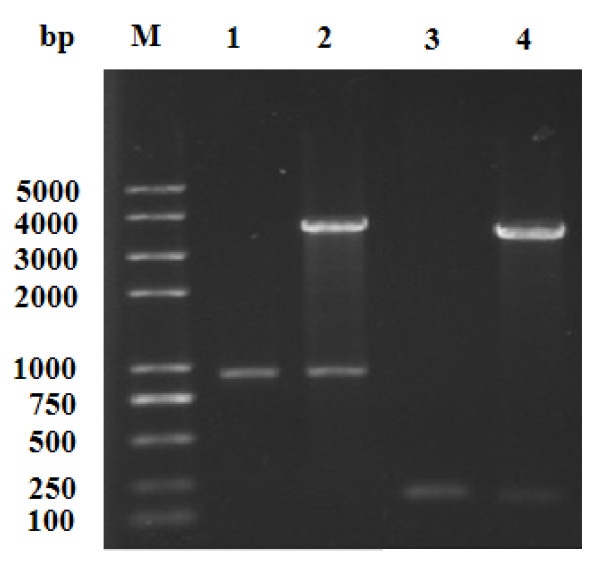
The identification of recombinant plasmid pSK-IE-BmRPSAand pSK-IE-dbp. The dbp or BmRPSA gene was inserted into the transient expression vector pSK-IE. Recombinant plasmid pSK-IE-BmRPSA and pSK-IE-dbp were analyzed by PCR and restriction enzyme digestion. M, trans plus II 2000; 1, PCR product of BmRPSA; 2, recombinant plasmid digested with EcoR I, and XhoI; 3, PCR product of dbp; 4, recombinant plasmid digested with EcoR I, and Xho I.